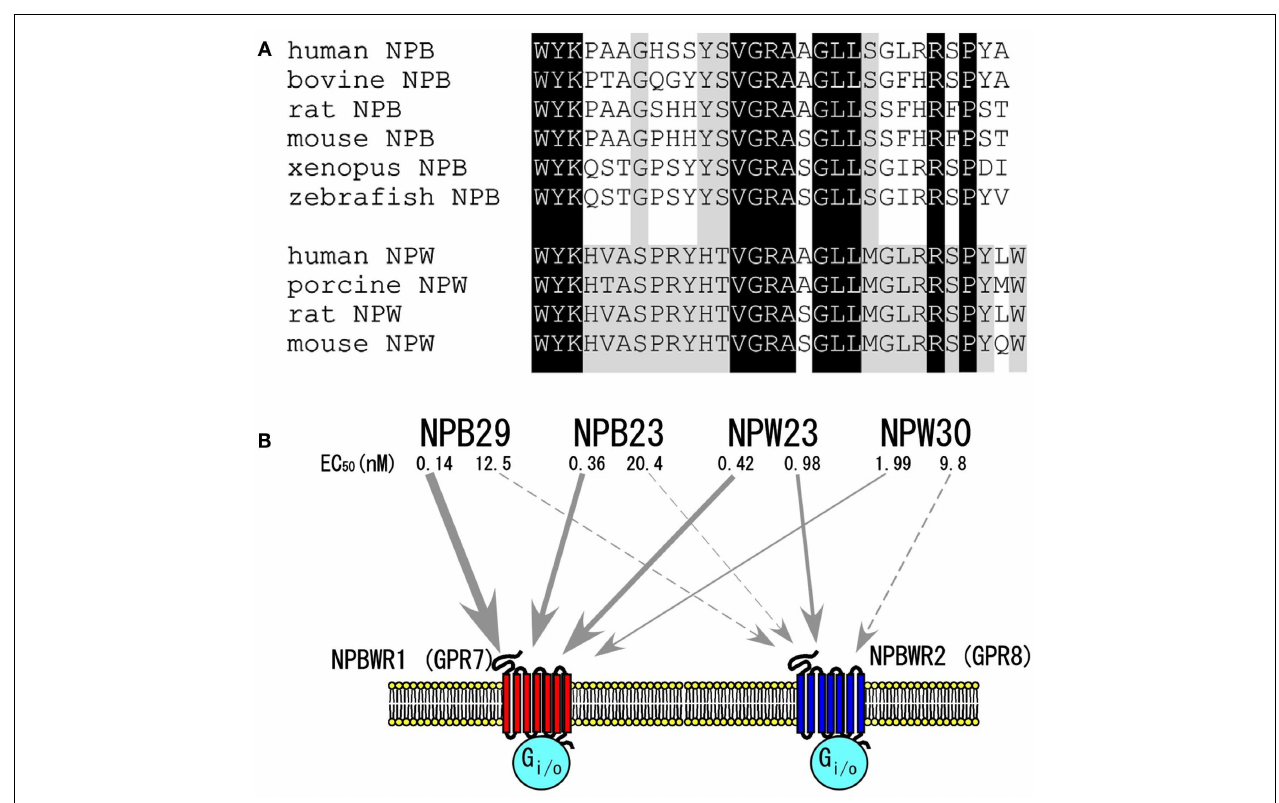
their receptors. EC 50 values were determined by assay of inhibition of cAMP production in CHO cells expressing each receptor (Brezillon et al., 2003). Modified from Hondo et al.